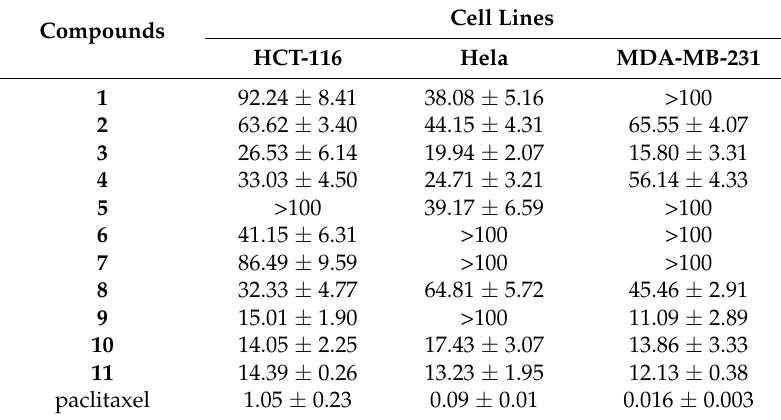
Table 5. IC 50 values ( µ mol/L) of compounds 1 – 11 against tumor cell